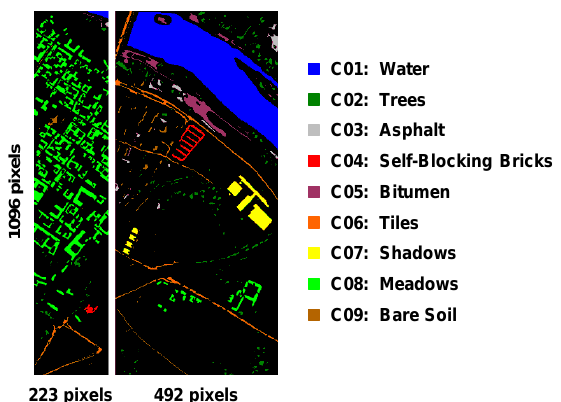
Figure 2. Reference labels for the Pavia Centre dataset: each pixel is characterized by reflectance values on 102 spectral